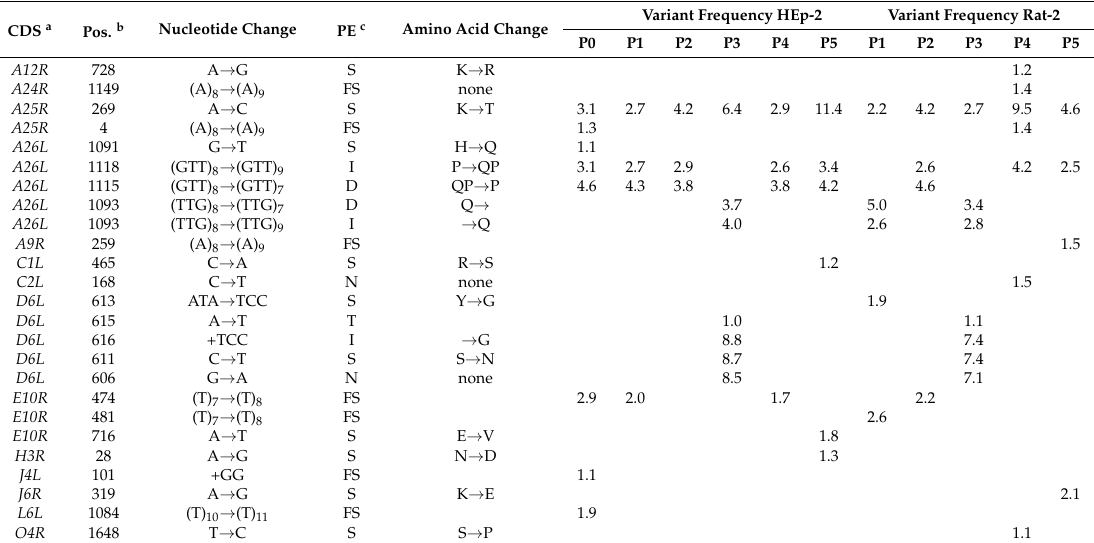
Table 1. Mutations in coding sequences during CPXV crust